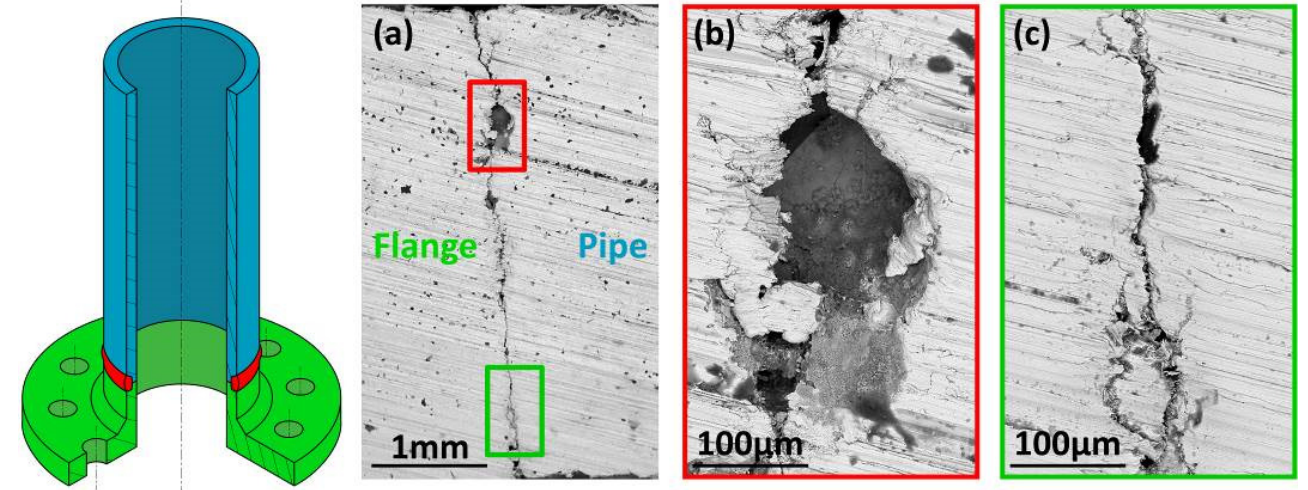
Figure 6. SEM analysis of one cracked area. Cracks are characterized by many branches and corrosion cavities. Images ( b , c ) are magnifications of picture ( a ).